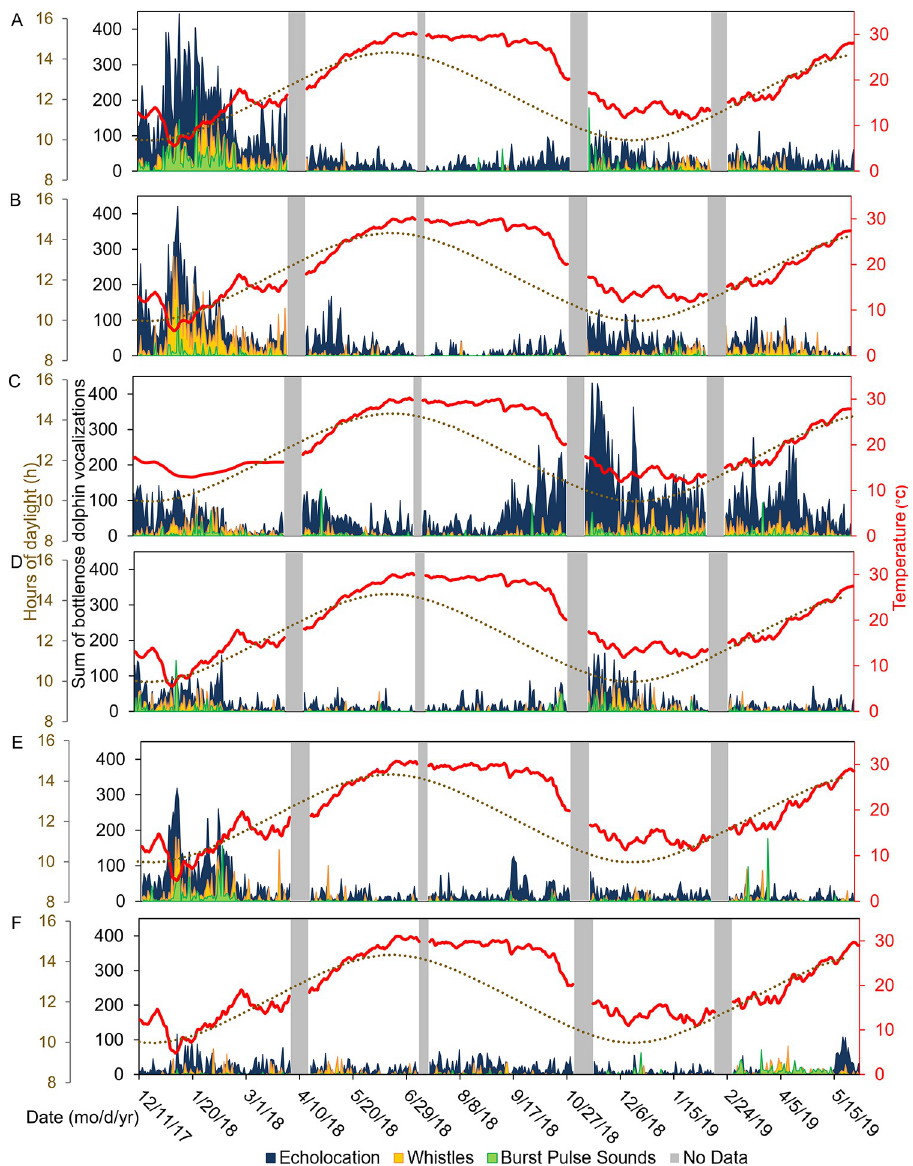
Fig 10. Time series of bottlenose dolphin vocalizations. Seasonal and spatial patterns of bottlenose dolphin vocalizations in Charleston Harbor, SC. Sums of vocalizations are shown from noon to noon the next day at (A) Wando River, (B) Drum Island, (C) SC Aquarium, (D) Fort Sumter, (E) Ashley River, and (F) Citadel stations. Also shown are hours of daylight (brown dotted line) and average daily water temperature (red line). Grey bars represent gaps in the data due to maintenance of equipment between